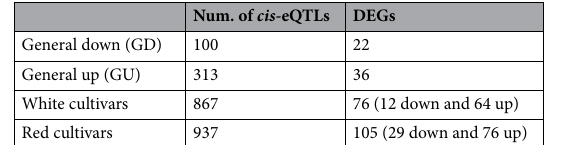
Table 1. Number of significant cis -eQTLs associations and number of related DEGs identified by the eQTL analysis.